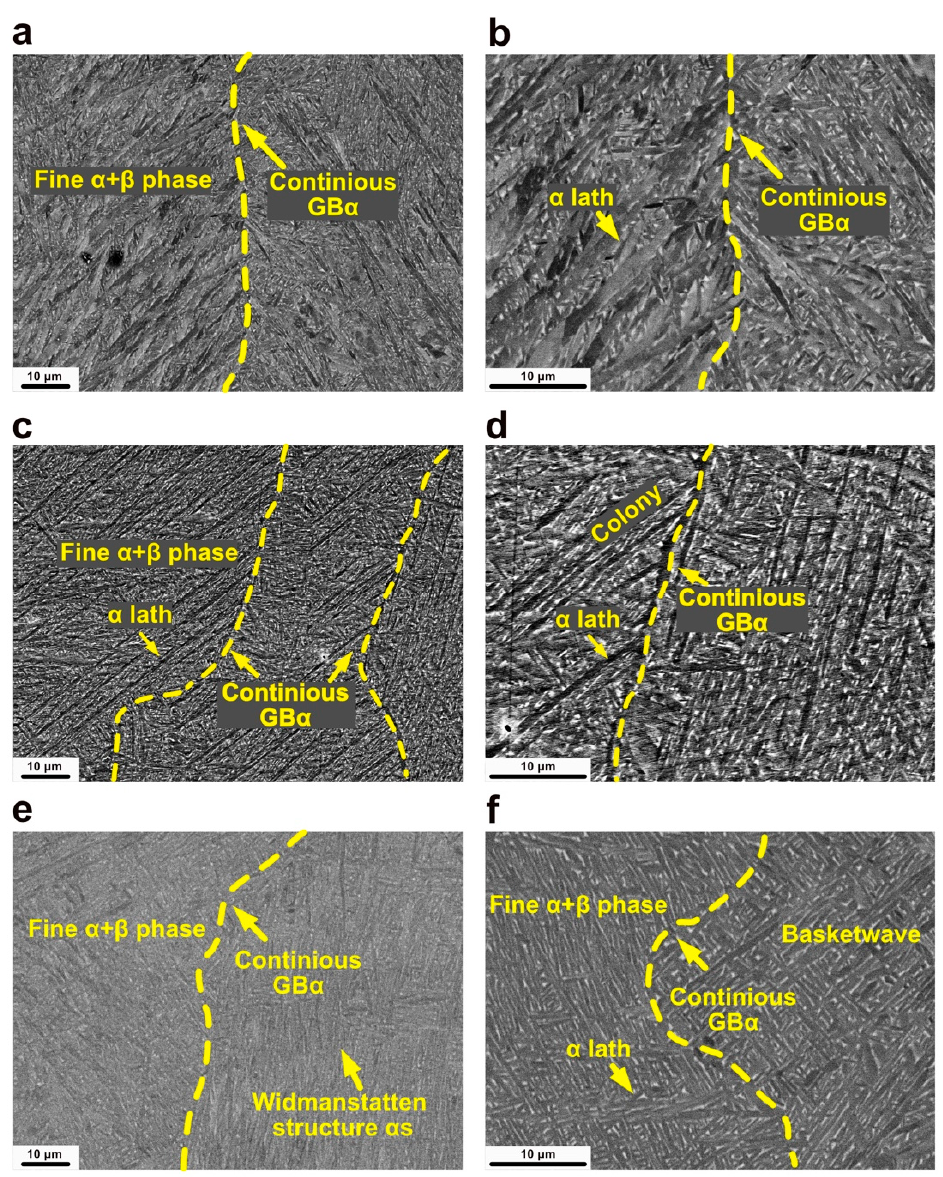
Figure 7. Microstructures in SLMed Ti64 with the different heat treatments, ( a , b ) 750-WQ, ( c , d ) 750-AC, ( e , f ) 750-FC.